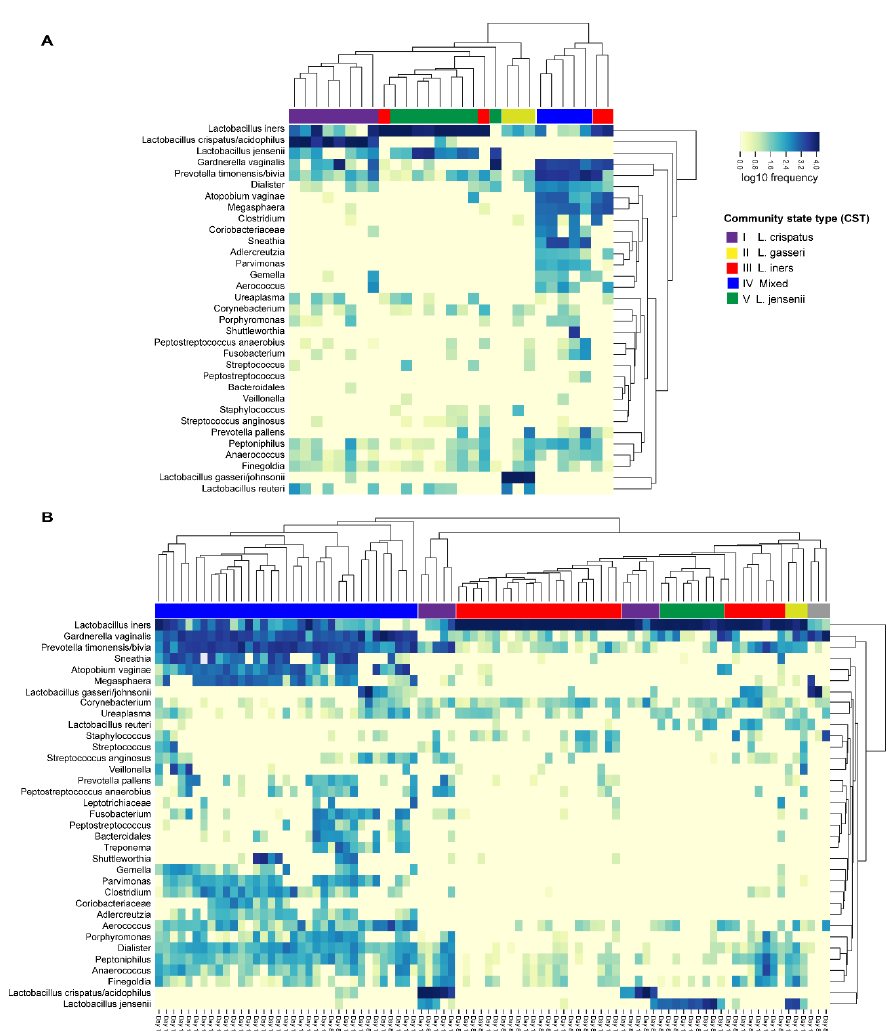
Figure 6. Distribution of vaginal microbiota community state types (CSTs) within ( A ) Group 1 (30 healthy women without BV symptoms, vaginal pH < 4.5) and within ( B ) Group 2 (30 BV ‐ positive women, vaginal pH > 4.5) on Day 1, Day 8, and Day 15 by hierarchical clustering.